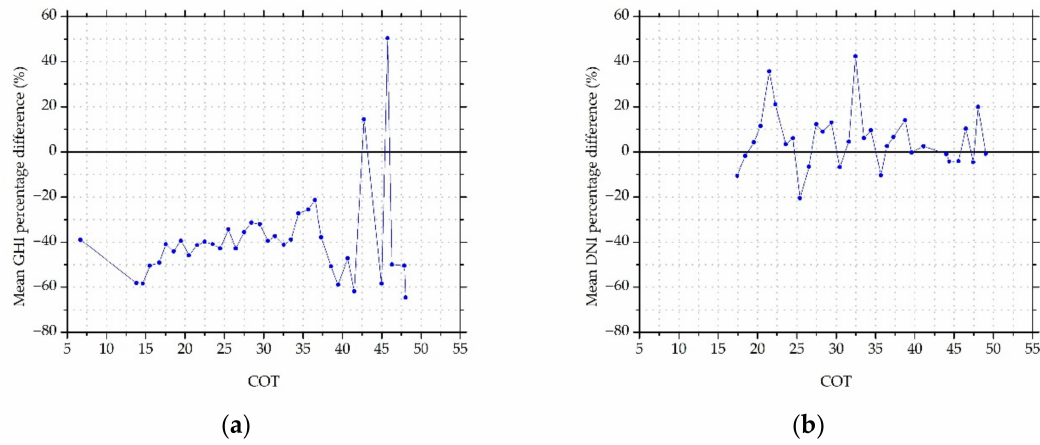
Figure 11. Mean percentage di ff erence of half-hourly ( a ) GHI and ( b ) DNI estimated from INSIOS as compared to BSRN measurements as a function of